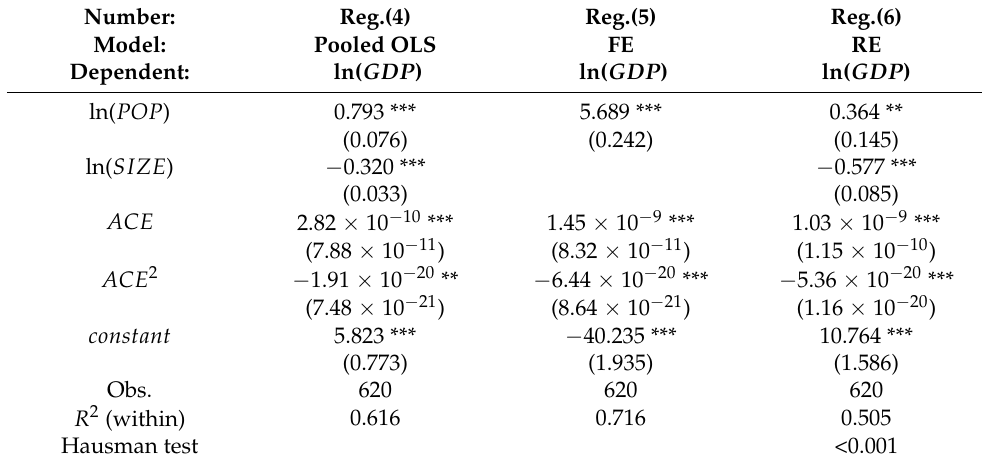
Table 5. Estimated Results of the